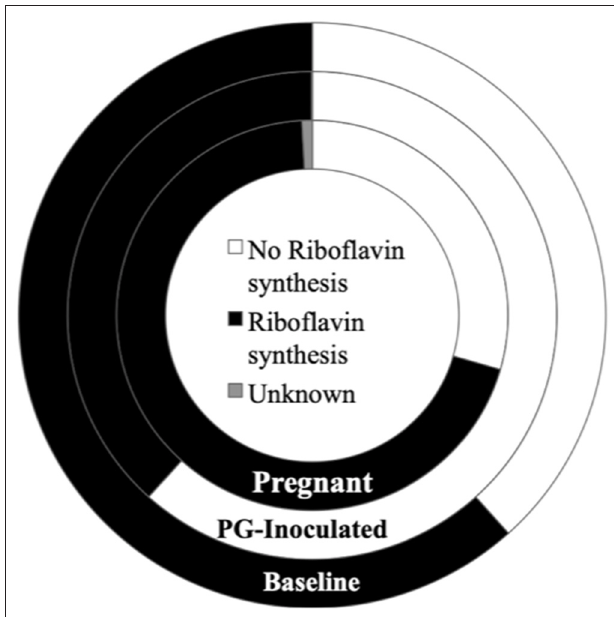
FIGURE 13 | Population proportion of identified community members in terms of predicted ability to synthesize riboflavin for baseline, PG-inoculated, and pregnant